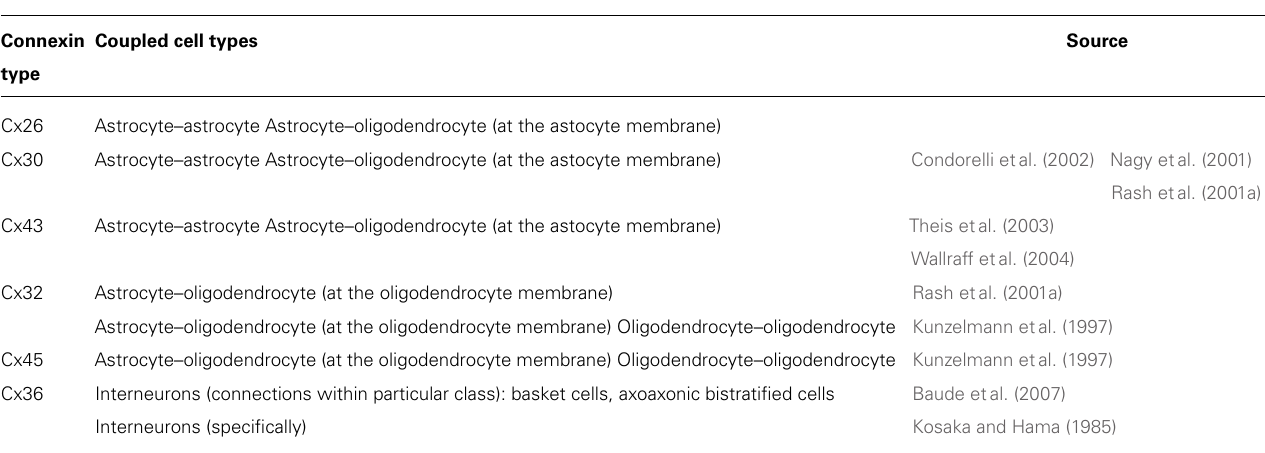
Table 1 | Connexin types in the hippocampal